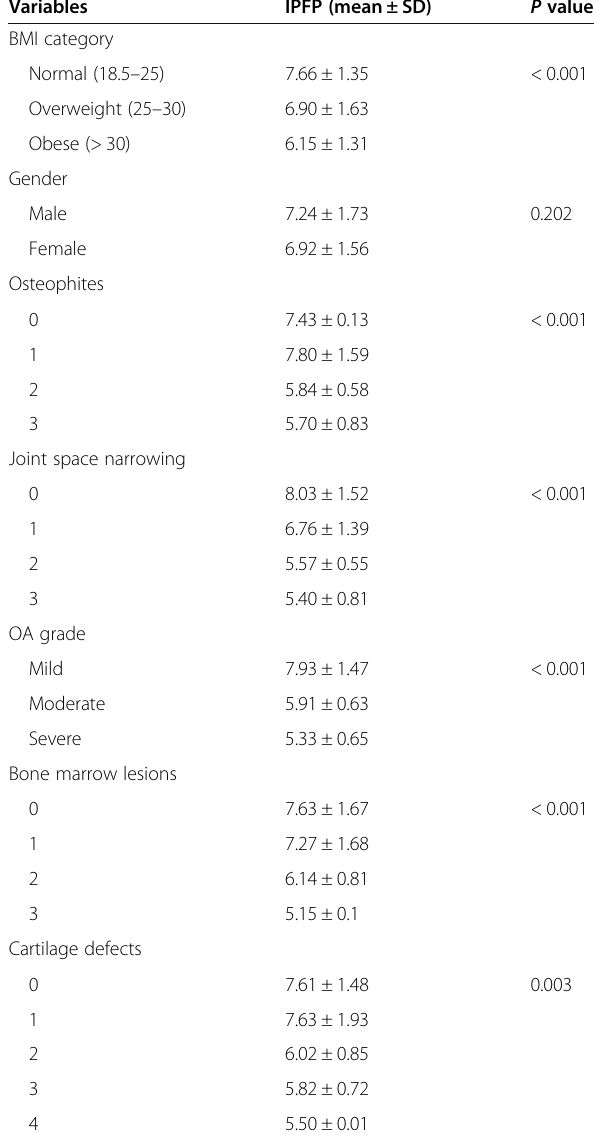
Table 3 Association between IPFP area and different manifestations of osteoarthritis, gender, and